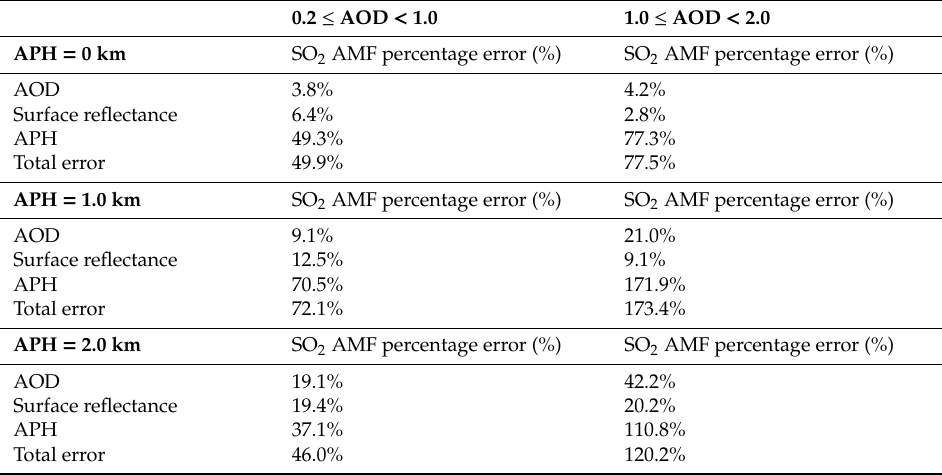
Table 4. Summary of PBL SO 2 AMF errors caused by uncertainties in APH, AOD, and surface reflectance based on the TROPOMI